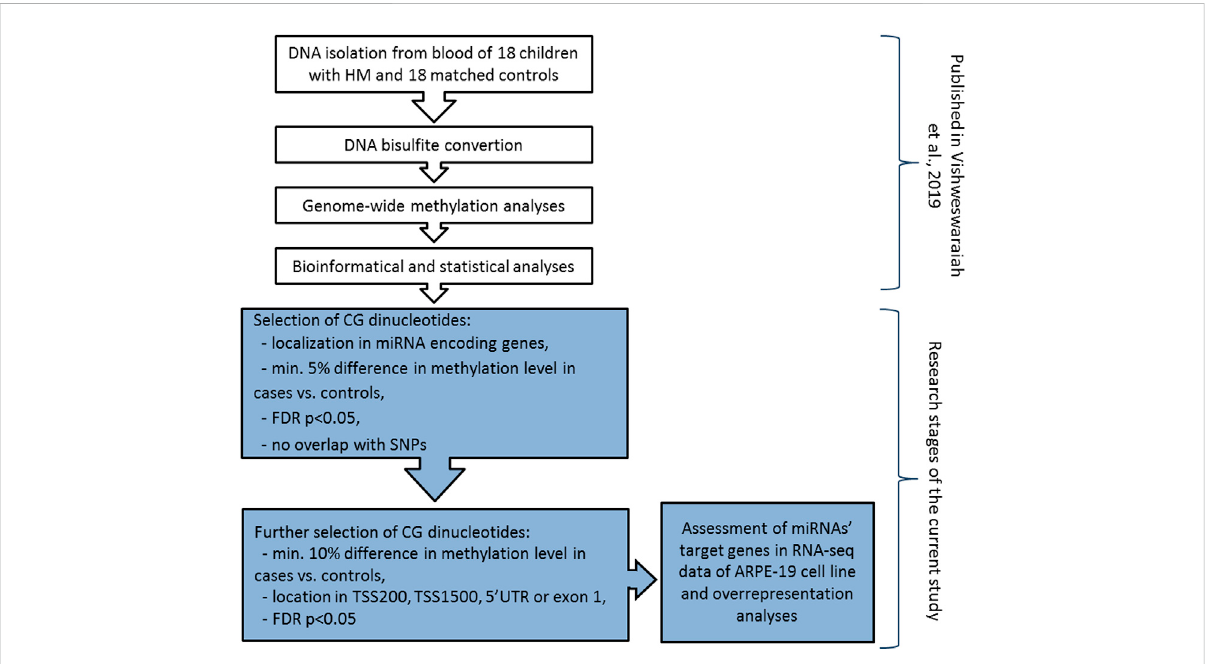
FIGURE 1 Detailed work fl ow of miRNA encoding genes methylation analyses in children with HM and matched controls. The research steps marked in white have been already published (Vishweswaraiah et al., 2019). Grey colour indicates the steps performed in the current study. TSS200